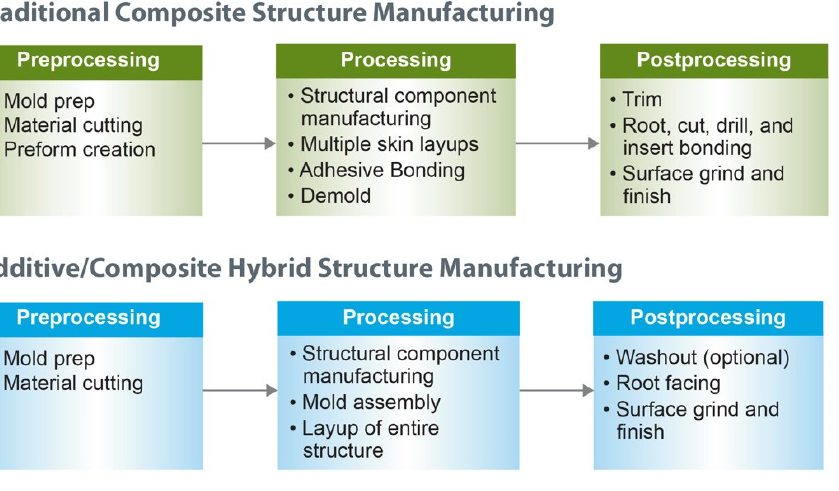
Figure 3. Comparison of the generalized traditional process steps required to manufacture composite tidal turbine blades [4,13] vs. those that are proposed using the additively manufactured internal molds with novel integrated features.